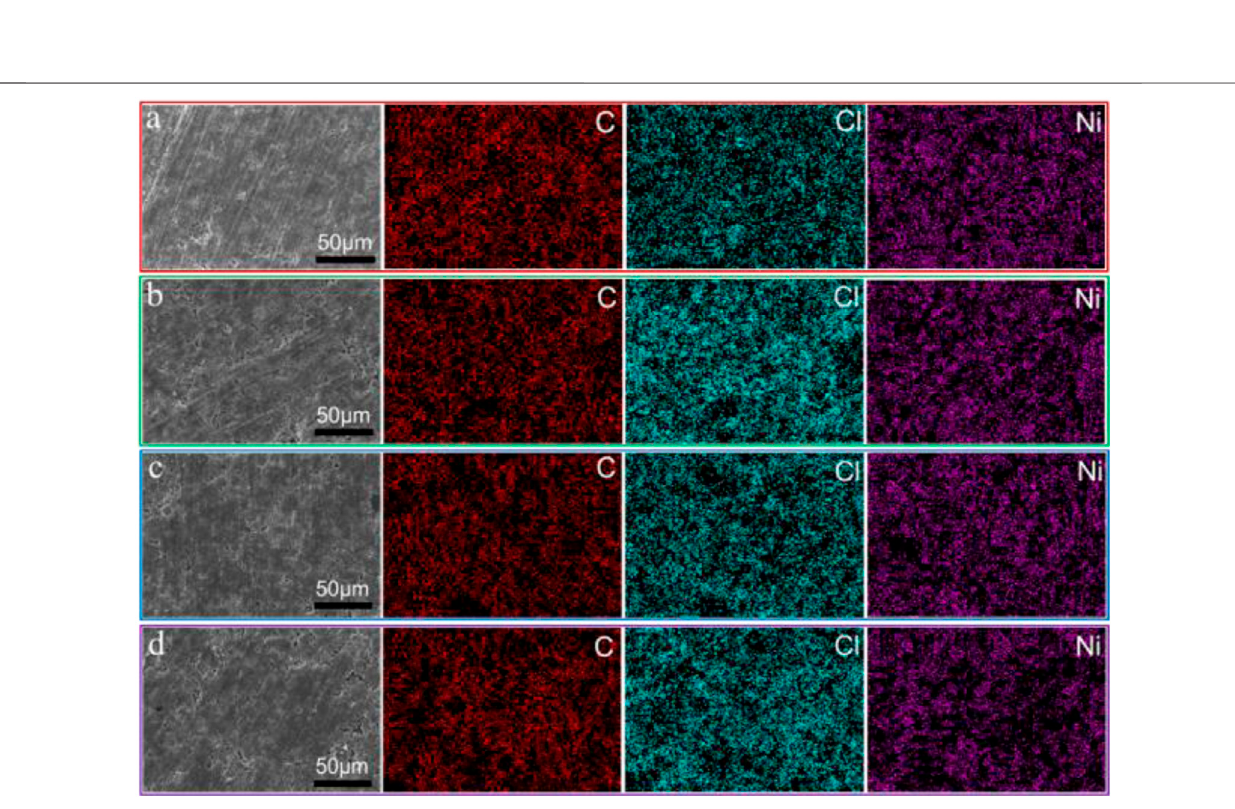
Frontiers in Materials |